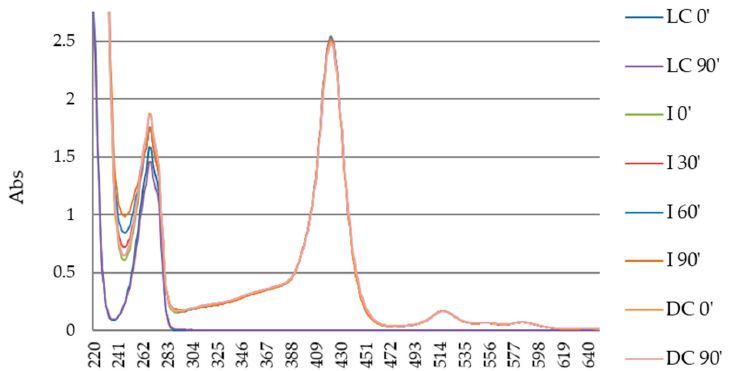
Figure 6. Photodegradation of phenol at a concentration of 100 mg L − 1 with artificial PAR white light (380–700 nm) with an irradiance of 40 W m − 2 and a Tetra-Py + -Me concentration of 25 µ M in PBS. These tests of photodegradation had an irradiation period of 90 min. Legend: light control (LC), dark control (DC), and irradiated samples (I) at different times of analysis.